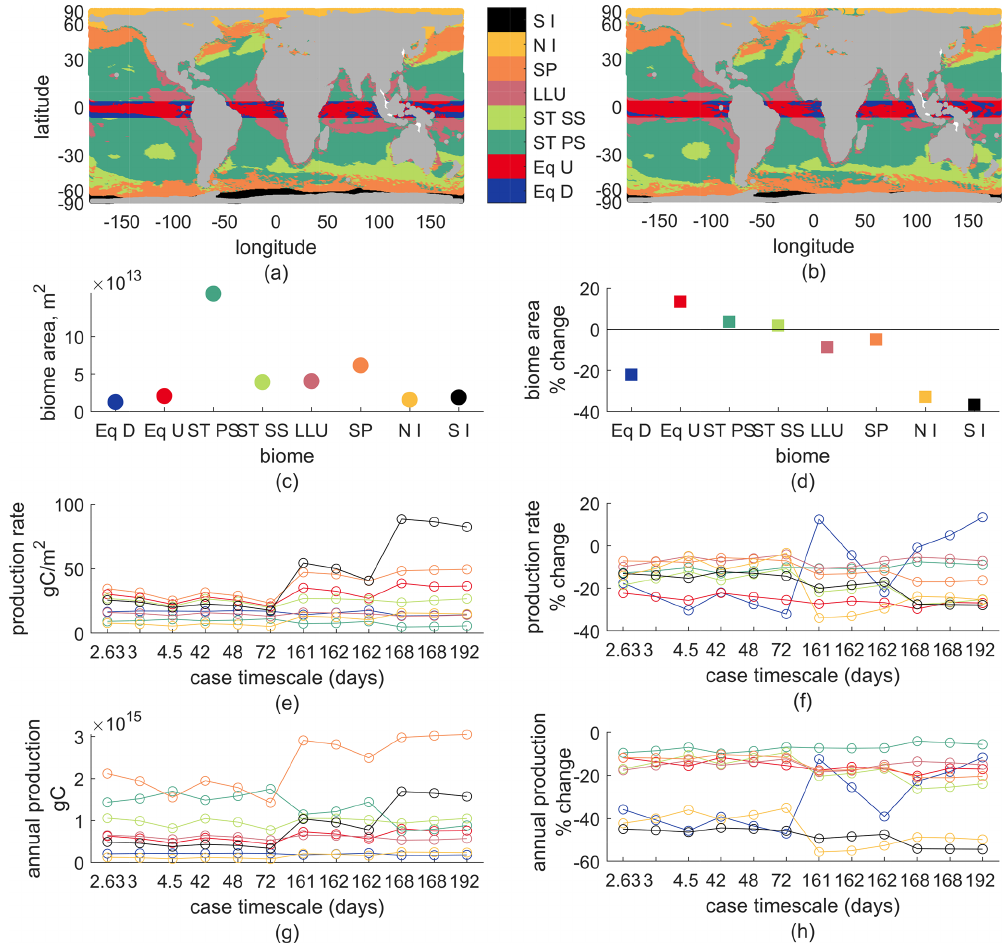
Figure B2. (a) Biomes for 2000, (b) biomes for 2100, (c) biome areas for 2000, (d) percent change in biome area – early–late-21st-century, (e) production rate – annual gC/m 2 for each biome (color) and each biogeochemical model parameter ( x axis, case timescale). (f) Percent change in production rate. (g) Total annual production for each biome and biogeochemical model parameter, which is c · e . (h) Percent change in total annual